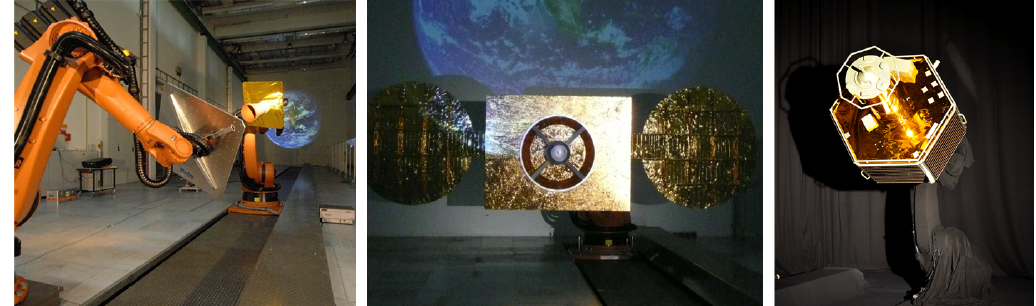
Figure 2: EPOS 2.0 facility - Physical part of the facility showing robots from different views and with different mockups and background. Left: two robots representing satellites in close proximity, center: large mockup with two antennas with a projection of the Earth in the background, right: large 3D mockup on a robot with black molton wrapping and with black